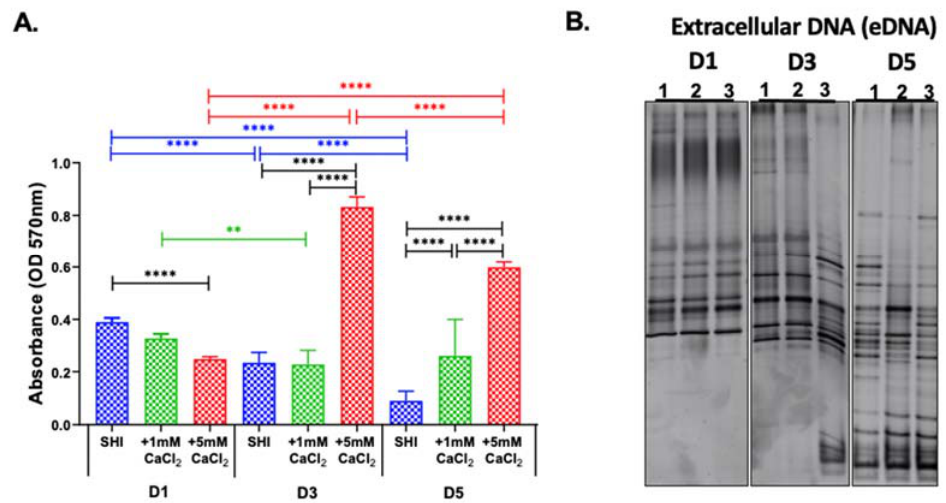
Figure 2. Characterization of oral microbial biofilms grown in SHI medium with CaCl 2 supplementation evaluated at day 1 (D1), day 3 (D3), and day 5 (D5). ( A ) Biofilm metabolic activity: The metabolic activity of the biofilms was assessed by measuring formazan formation from MTT at the optical density of 570 nm. ** Represents p ≤ 0.01, and **** represents p ≤ 0.0001 ( B ) Extracellular DNA (eDNA) composition: eDNA is a ubiquitous and pivotal component of biofilm. Denaturing gradient gel electrophoresis (DGGE) profiles of eDNA of oral microbial biofilms grown in 1. SHI medium, 2. SHI medium + 1 mM CaCl 2 , and 3. SHI medium + 5 mM CaCl 2 at day 1 (D1), day 3 (D3), and day 5